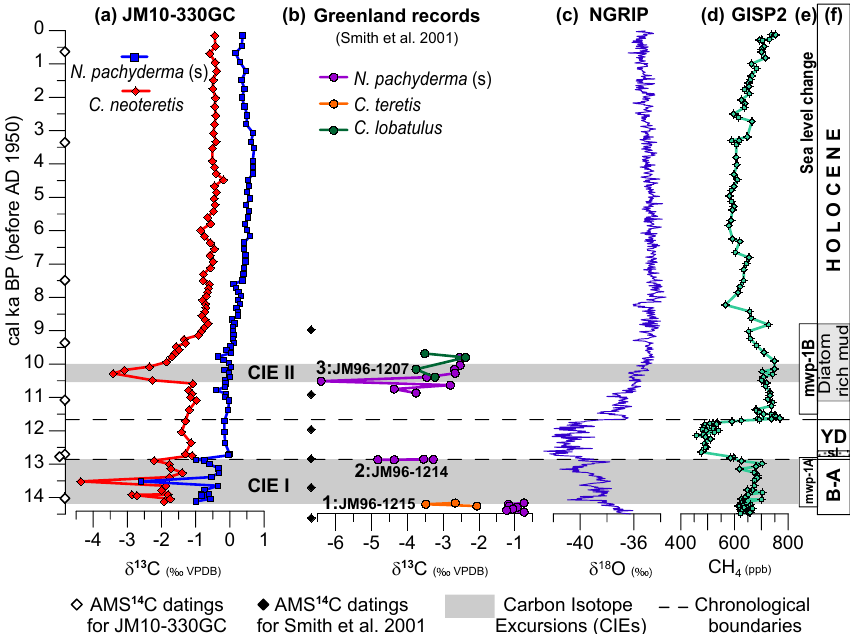
Figure 10. Isotopic data of core JM10-330GC and other records plotted versus cal ka BP (before AD1950): (a) δ 13 C record of N. pachy- derma (s) (blue line) and of C. neoteretis (red line) from JM10-330GC; (b) δ 13 C negative excursions from east Greenland continental shelf (Smith et al., 2001): event 1 from core JM96-1215, event 2 from core JM96-1214, and event 3 from core JM96-1207; (c) NorthGRIP ice core δ 18 O record (Andersen et al., 2004); (d) Greenland Ice Sheet Project 2 (GISP2) atmospheric CH 4 record (Brook et al., 2000); (e) melt water pulse mwp-1A and mwp-1B (Peltier and Fairbanks, 2006; Stanford et al., 2011); (f) stratigraphy obtained for JM10-330GC with chronological subdivisions (dashed lines). White diamonds on the y axis indicate dating points for JM10-330GC (next to plot a ) and black diamonds next to plot (b) are dating points for cores of Smith et al. (2001). Shaded horizontal bars indicate carbon isotope excursions CIE I and CIE II. Abbreviations: B-A, Bølling–Allerød; YD, Younger Dryas; sl, sandy